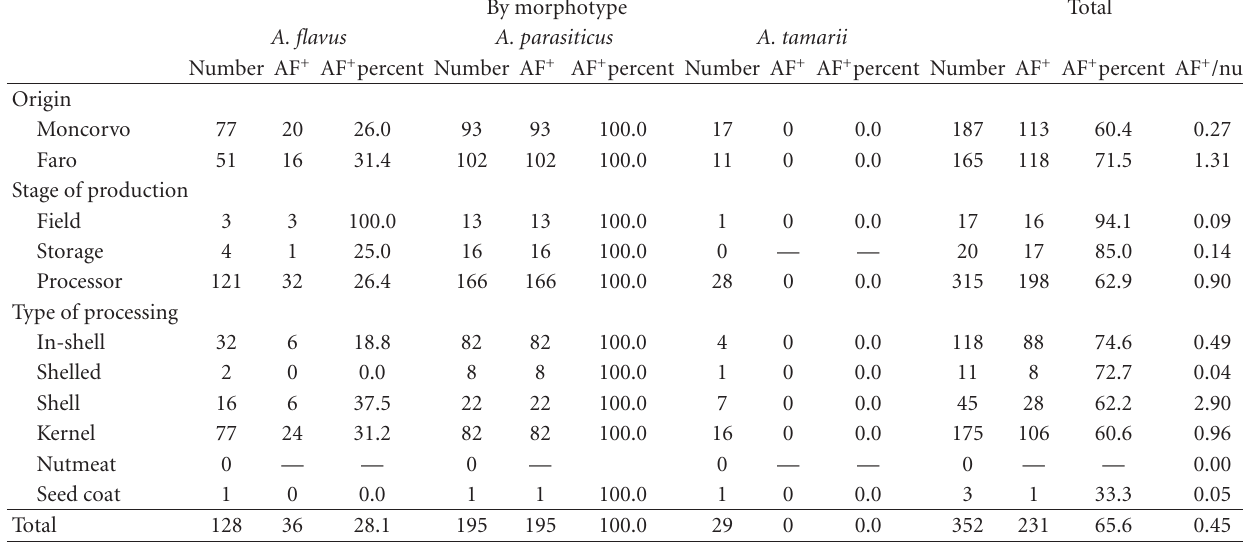
Table 3: Number of isolates and percentage of AF producers of each morphotype, grouped by origin, stage of production, and type of processing.